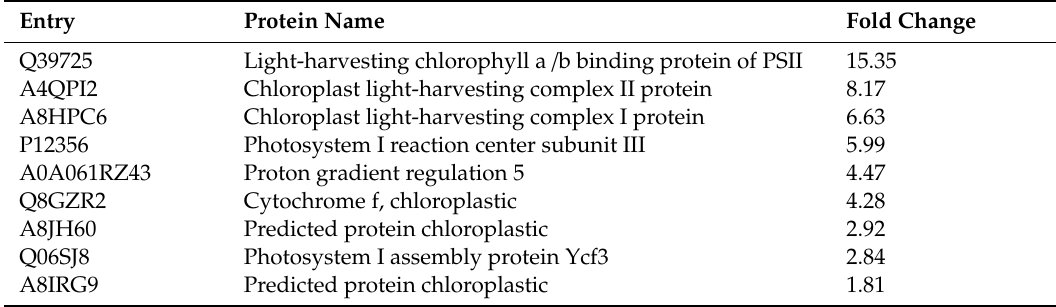
Table 3. The chloroplast related proteins increased in abundance in the Z-strain treated with Cd.